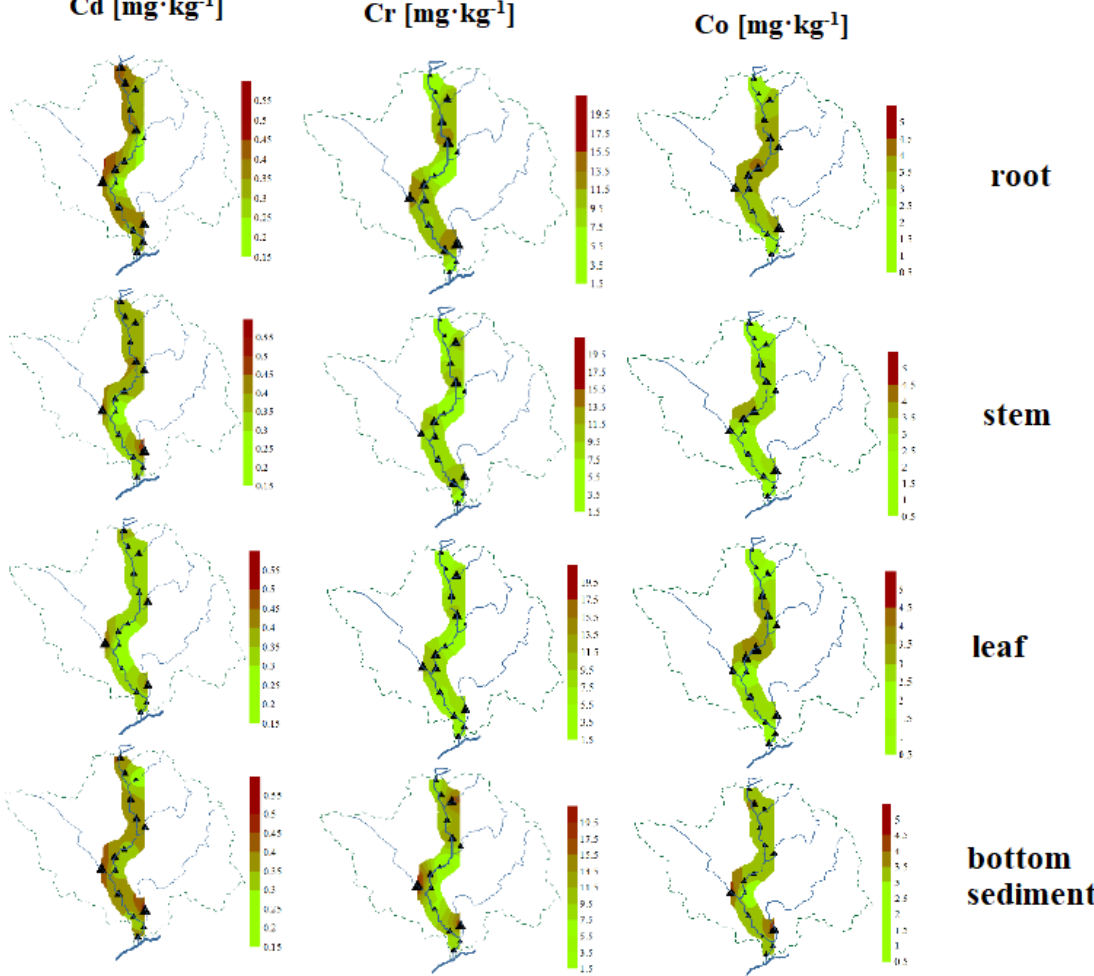
Figure 6. Spatial distribution of PTEs (Cd, Cr, Co) in roots, stems, and leaves of aquatic plants and bottom sediments on the Pisa River and its tributaries.